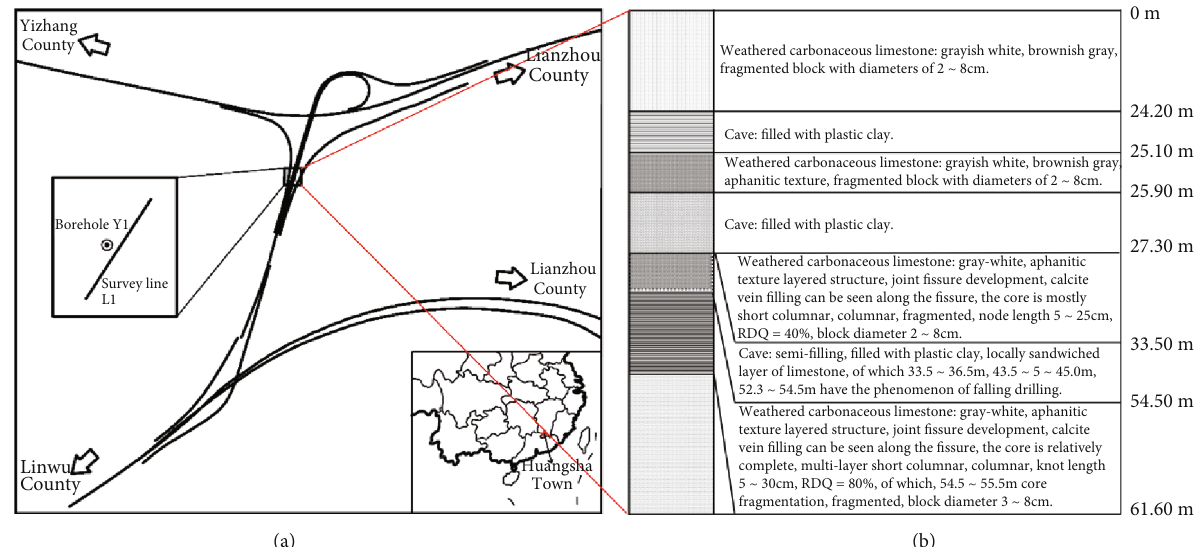
Figure 3: Location and geologic column of Caojiaben interchange main line bridge.